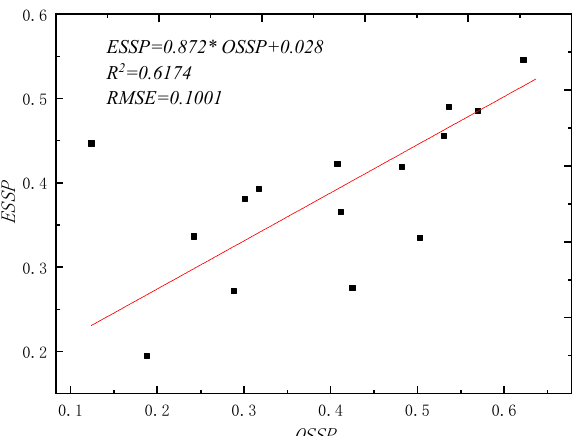
Figure 3. Relationship between the observed (OSSP) and estimated spatial structural parameters (ESSP) of restored forests in semi-arid mine dumps for validation analyses using a regression model (* represents multiplication).